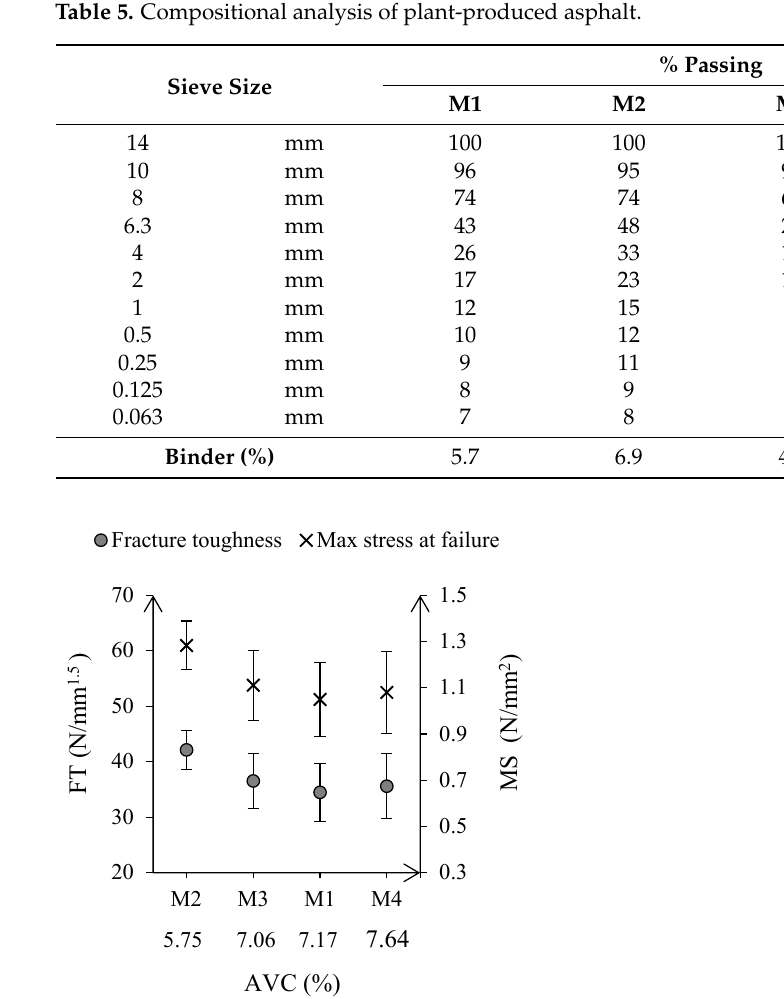
Figure 6. Results from semi-circular bending test and air void content calculations.